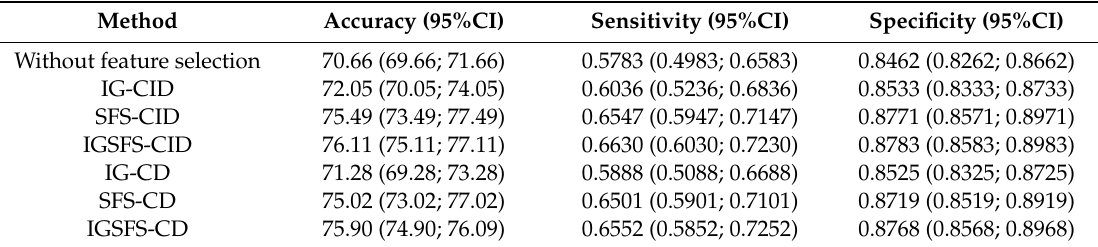
Table 11. Estimate of accuracy, sensitivity, and specificity for LC_dataset-1.